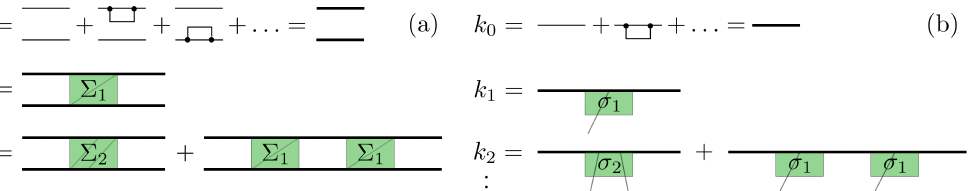
Figure 9: Hierarchies for propagators (a) on the double-branch and (b) on a single branch of the Keldysh contour. Each tier of the hierarchy corresponds to a physical process. The tier index (28) indicates the modes of the contracted lines in (a) and external uncontracted lines in (b). Horizontally cutting the Π diagrams in (a) pro- m duces the corresponding k diagrams in (b) and the converse is given by Eq. (21b). m Cutting the self-energy diagrams Σ in (a) produces the diagrams σ in (b) when m m discarding one-branch reducible fragments. The nontrivial converse construction of Σ [ σ ] is described in Sec. 4.3. Although this figure shows examples for bi- ... Σ m m 0 linear coupling, all considerations also hold for multilinear coupling V